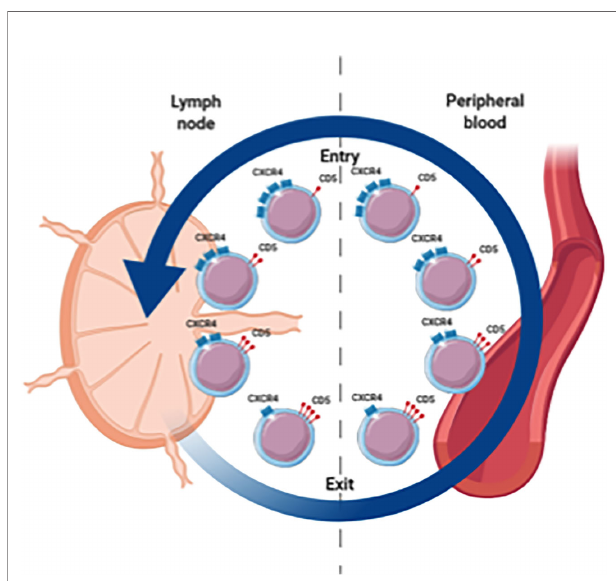
FIGURE 1 | Spectrum of circulating CLL cells illustrating the proliferative fraction enriched in LN emigrants versus the resting fraction enriched in LN immigrants. CXCR4high/CD5low cells are in a resting state. When these cells are activated in the LN, CD5 is upregulated and CXCR4 is internalized. These CXCR4low/CD5high cells are released from the LN and migrate into the PB. Eventually these cells become more quiescent leading to downregulation of CD5 and renewed surface expression of CXCR4 which increases the likelihood of a return to the